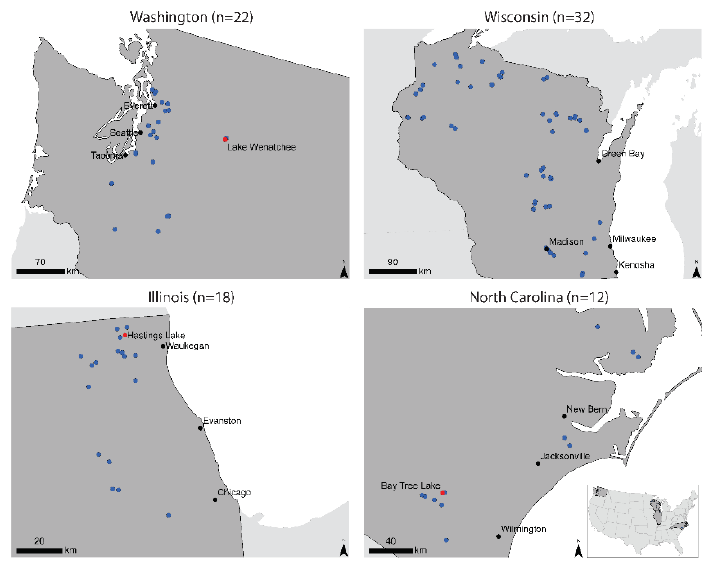
Figure 1. Lake gauge locations in each study region. Blue dots indicate study lakes, while red dots represent